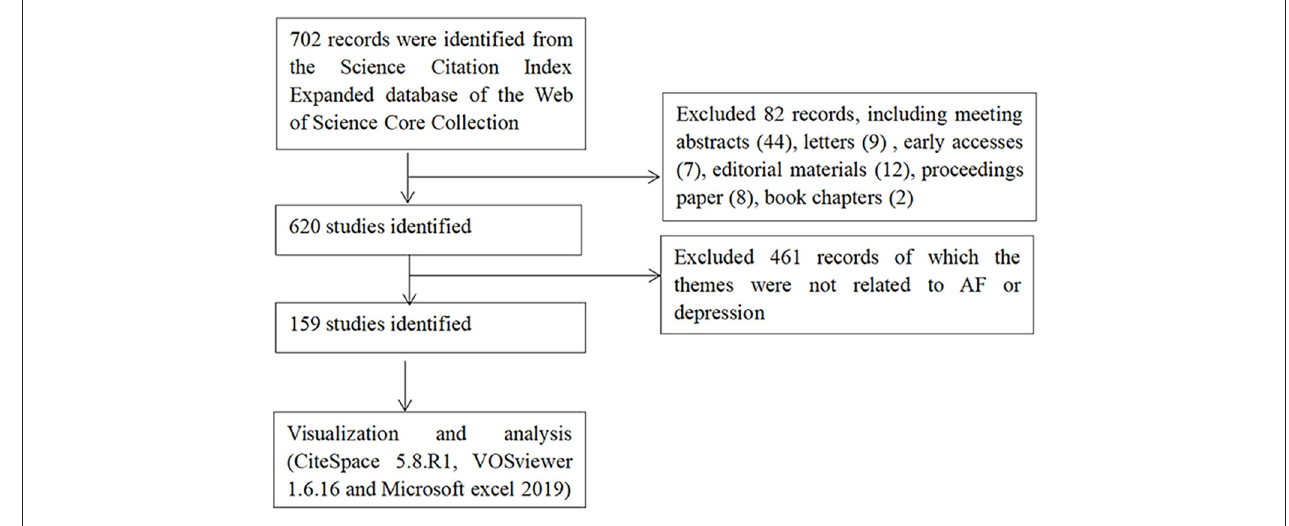
FIGURE 1 | Flowchart of literature selection.